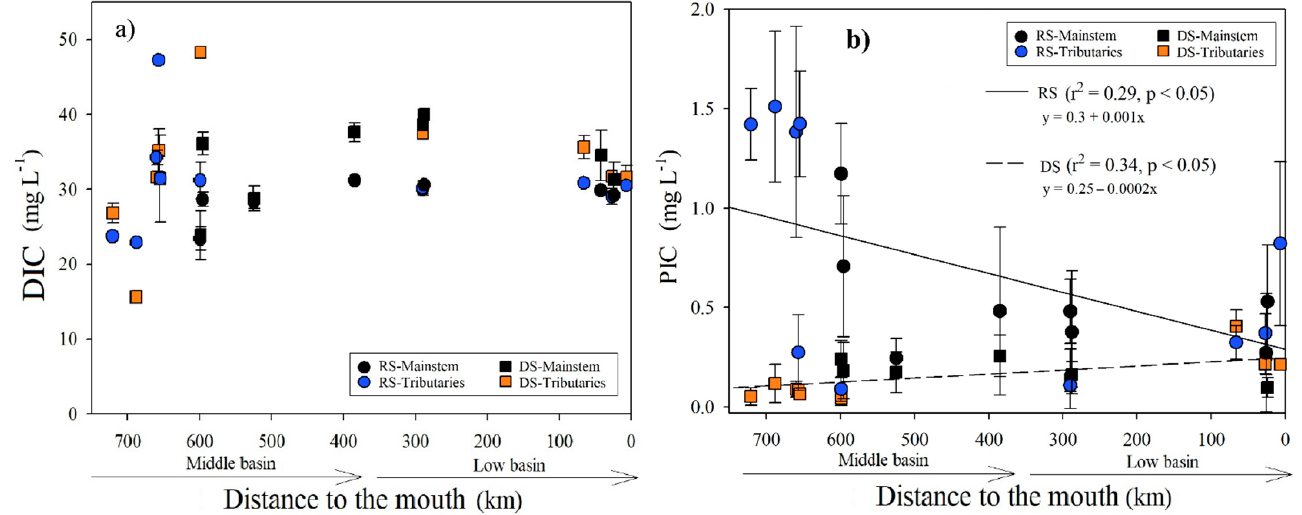
Figure 6. ( a ) Longitudinal variations in the DIC and ( b ) PIC concentrations (±SD) according to the distance to the Usumacinta River’s mouth during the rainy (RS) and dry (DS) seasons. The mainstem differs in both seasons from the tributaries.